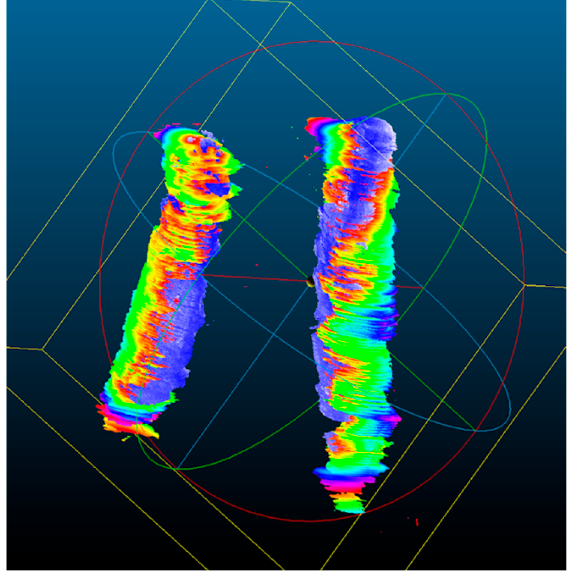
Figure 6. Patient 1, scan 2, circulated lumen evaluated with Patient 1, scan 1, circulated lumen as reference, aligned using CCOSS. The 100% overlapped 3D points are blue; the most distant points are represented in red.